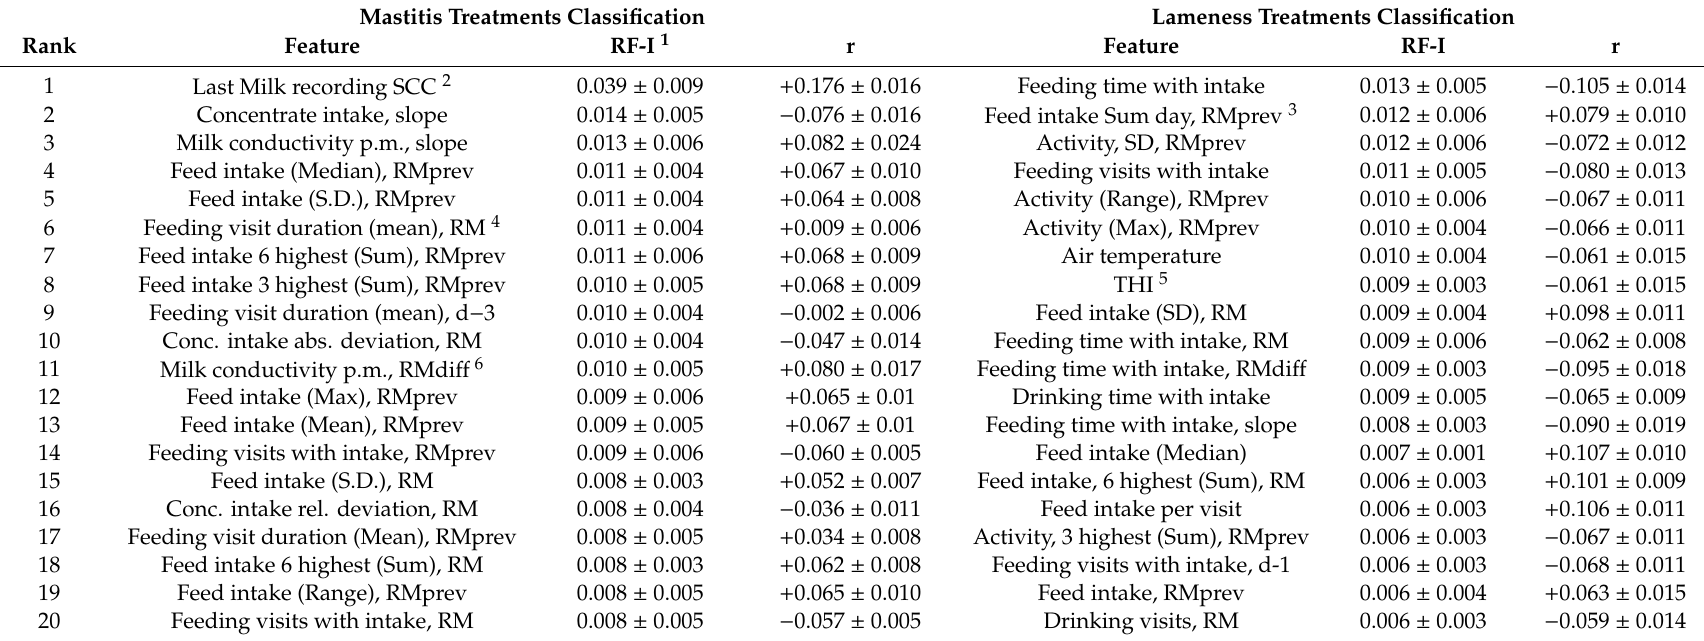
Table 3. The 20 most important variables ranked by RF-I (mean ± 95% CI) with respective r-values (mean ± CI, all correlations with p < 0.001). Mastitis Treatments Classification Lameness Treatments